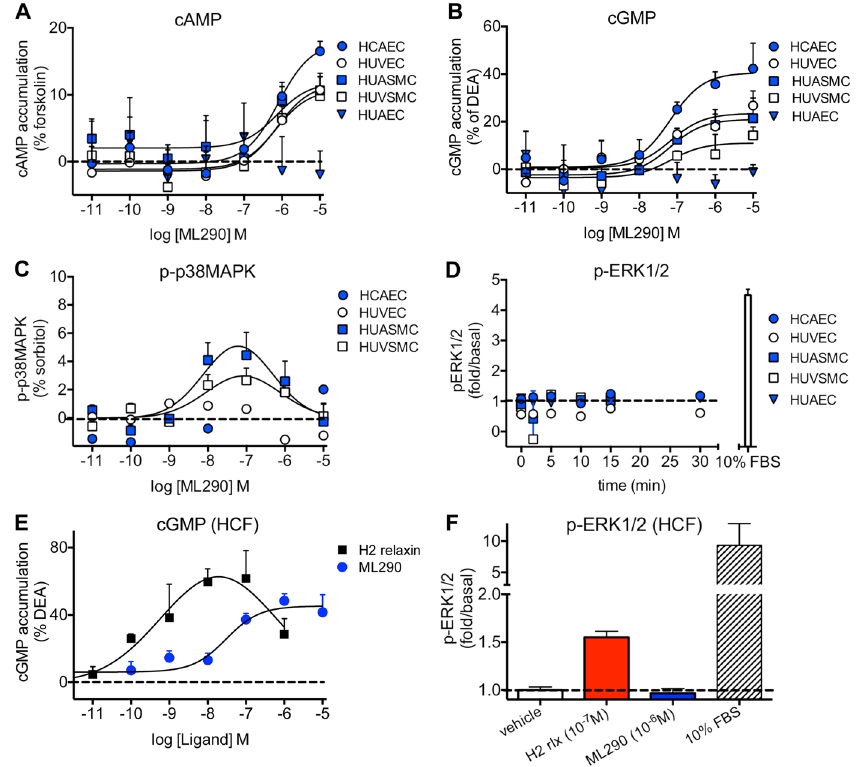
Figure 4. Signal transduction pathways activated by ML290 in human primary vascular cells and in human cardiac fibroblasts (HCF). In ( A ) ML290 (30 min) concentration-dependently increased cAMP accumulation in HCAECs ( , n = 7), HUVECs ( , n = 7), HUASMCs ( , n = 5), HUVSMCs ( , n = 4) but not in HUAECs that do not express cell surface RXFP1 ( , n = 4); in ( B ) ML290 (30 min) also increased cGMP accumulation in HCAECs (n = 7), HUVECs (n = 7), HUASMCs (n = 7), HUVSMCs (n = 4) but not in HUAECs (n = 4); In ( C ) ML290 increased p-p38MAPK (15 min) but only in HUASMC and HUVSMCs (n = 3); In ( D ) ML290 did not cause ERK1/2 phosphorylation in HCAECs (n = 3), HUVECs (n = 3), HUASMCs (n = 3), HUVSMCs (n = 3) or HUAECs (n = 3). In HCFs, H2 relaxin activated cGMP accumulation in a concentration-dependent manner (( E ) n = 5) (40 min) and p-ERK1/2 (( F ) n = 3) (5 min). ML290 did not activate p-ERK1/2 (F; n = 3) but did induce cGMP accumulation (E; n = 5) in a concentration-dependent manner albeit with lower potency than H2 relaxin. Data shown are mean ± SEM of ‘n’ independent